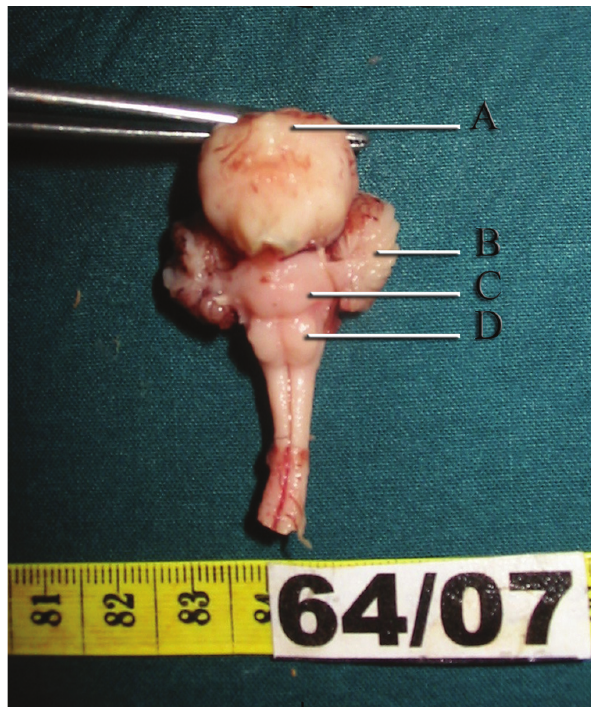
Figure 3: Brain stem.(A) Rudimentary diencephalon; (B) hypoplas- tic cerebellar structures; (C) pons; and (D) well-formed olives, no